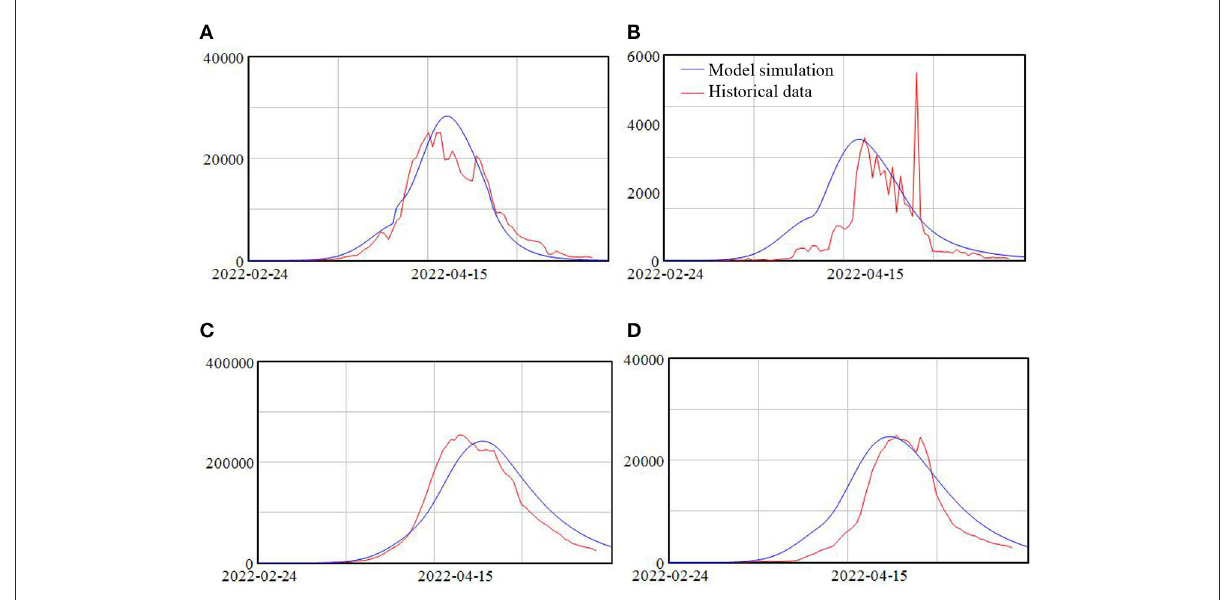
FIGURE2 (A–D) Model simulation result and historical data.